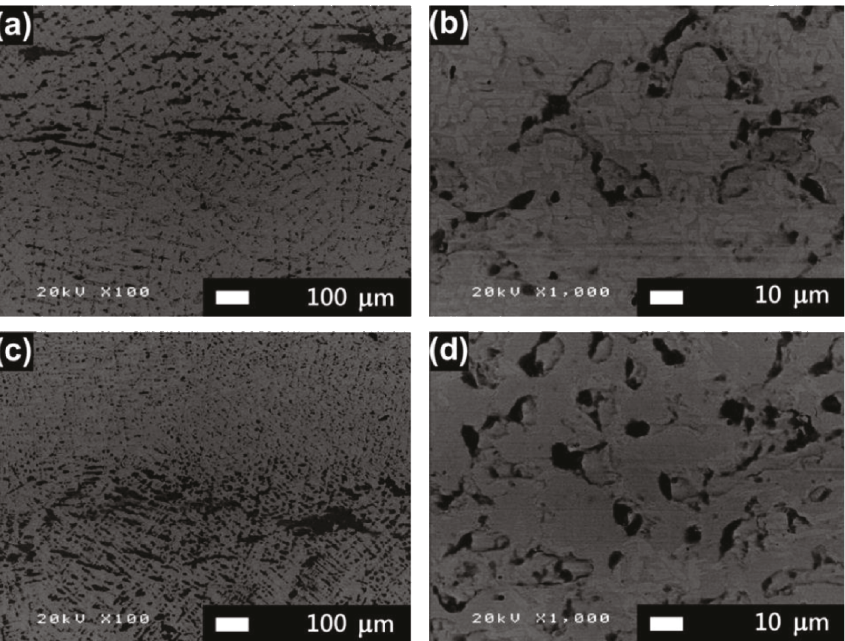
Figure 24: SEM BEI of worn-out morphology on Al00Ti10: (a) magnification 100X and (b) magnification 1000X; Al02Ti10: (c) mag- nification 100X and (d) magnification 1000X [33]. Table 4: Elementary Composition of dark areas in the worn surface of HEAs [33]. HEA O Al Ti Cr Fe Al00Ti10 (at. %) Al02Ti10 (at. combinations of HEAs to improvise their future application.